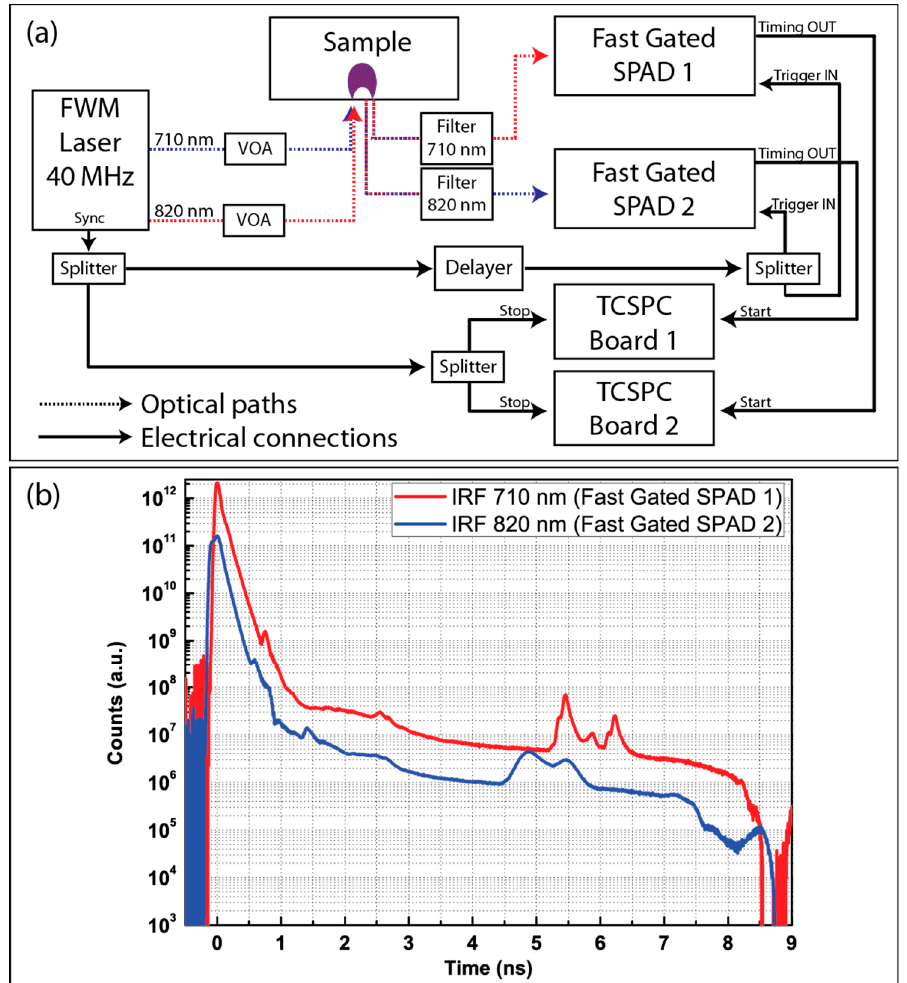
Figure 1. ( a ) Schematics of the setup used for the in vivo experiment. ( b ) Instrumental response function recorded for both fast-gated single-photon avalanche diode (SPAD) modules at their operating wavelengths (710 nm for fast-gated SPAD (FG-SPAD) 1—red line; and 820 nm for FG-SPAD 2—blue line). Time bin size: 3.05 ps. IRF = instrument response function, VOA = variable optical attenuator, TCSPC = time-correlated single photon counting. FWM: Four Wave Mixing.